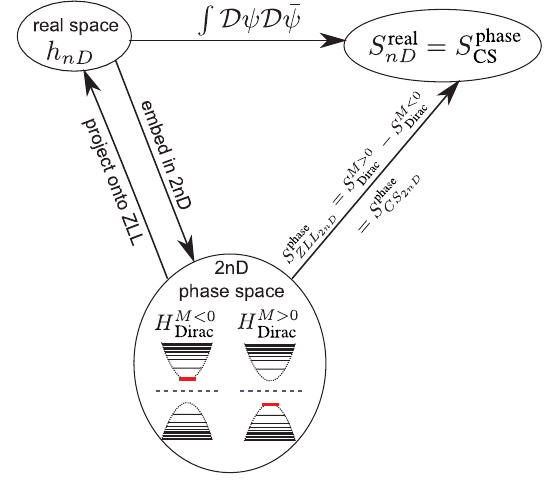
FIG. 2. Logical flow of the derivation in Sec. IV. An nD Hamiltonian h can be obtained by projecting a 2 nD massive nD in a magnetic field onto the ZLL, Dirac Hamiltonian H M Dirac denoted by the thick red bar. For a Fermi level in the Dirac mass gap, the M > 0 and M < 0 ground states differ only in the occupation of the ZLL, while their response theories S M differ Dirac by the CS term in 2 nD . Thus, the response theory of the ZLL S , which is the real-space response theory S real of h , is the nD ZLL 2 nD nD phase-space CS theory S phase CS